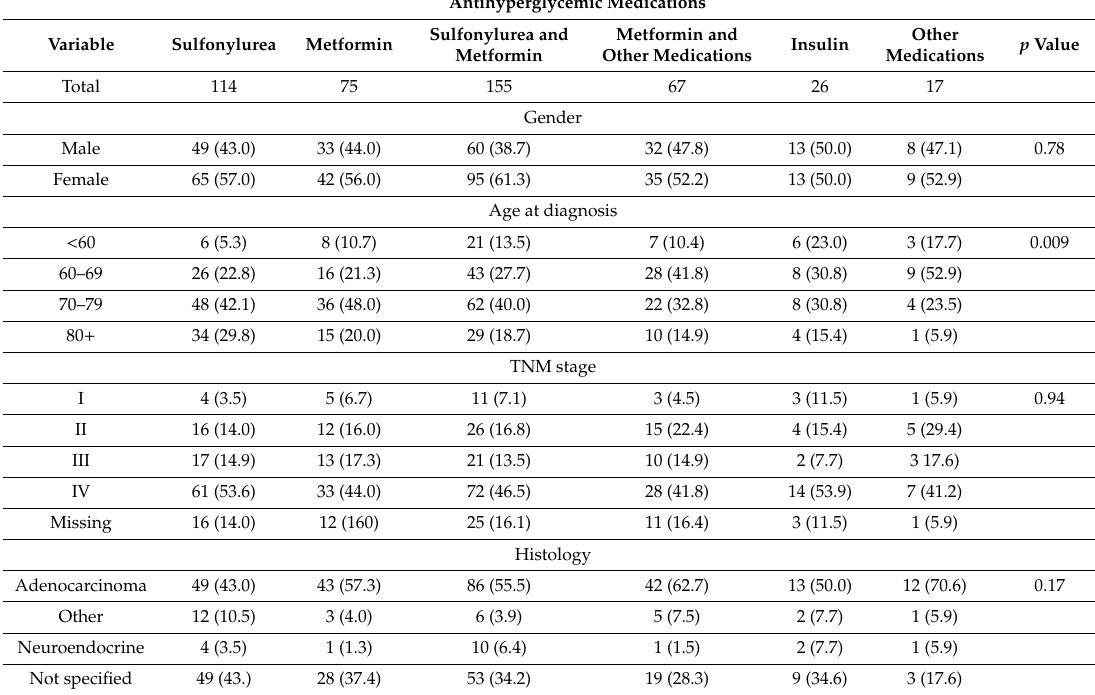
Table 1. Demographic and clinical characteristics of pancreatic cancer patients by glucose-lowering